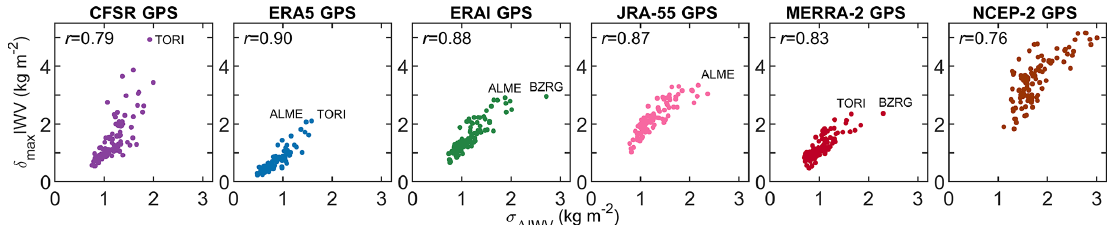
Figure 3. Scatterplots showing the relationships between the standard deviations of daily IWV difference ( σ (cid:49) ) and the representativeness error statistic ( δ max ) for the 108 GPS stations.